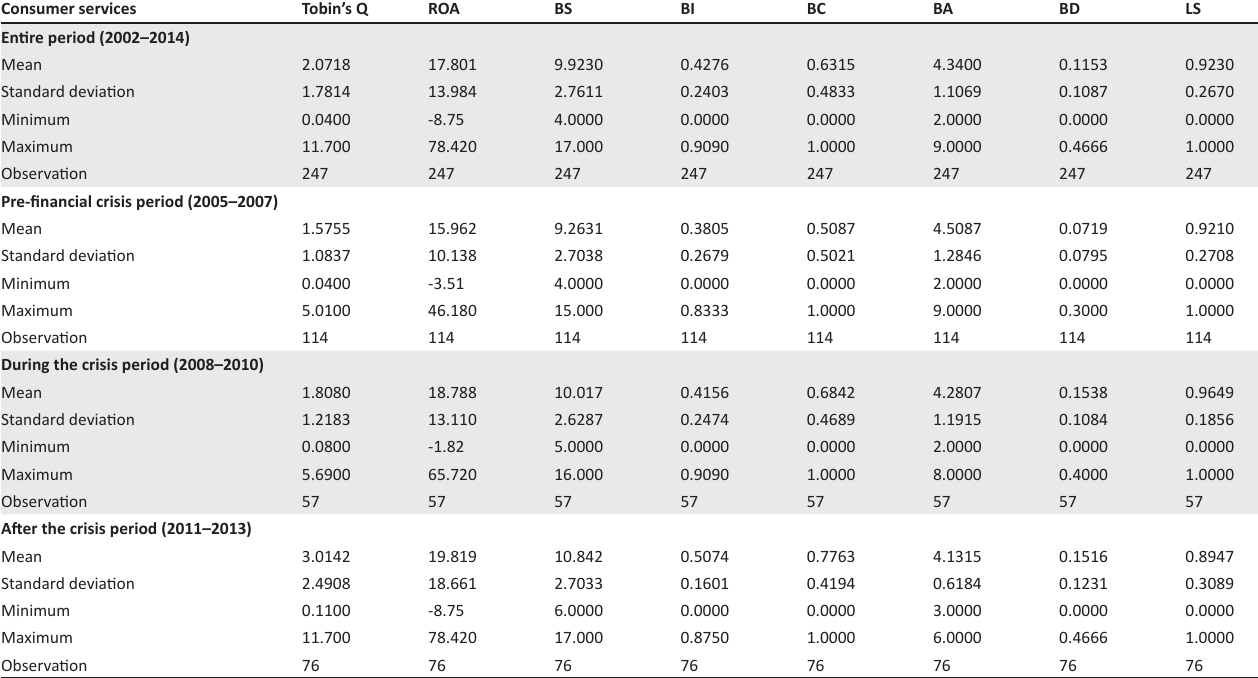
Table 1-A3: Descriptive statistics for the consumer services